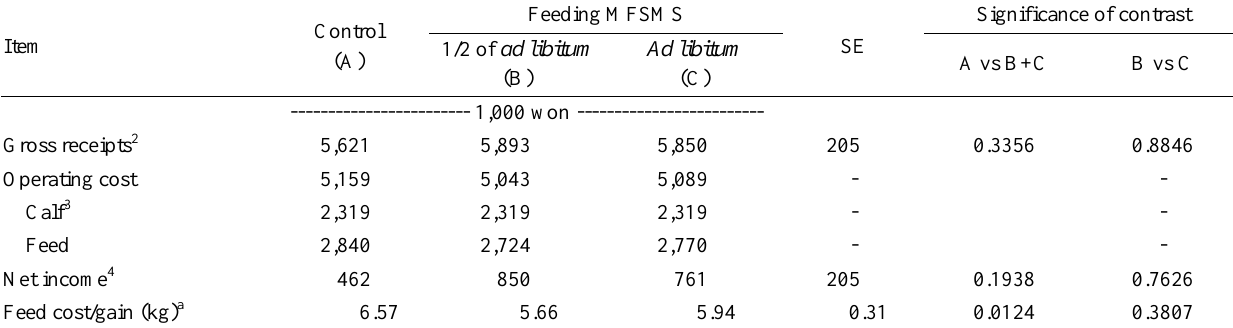
Table 6. Effect of dietary supplementation of microbially-fermented spent mushroom substrates (FMSMS) on economic profit of Hanwo steers